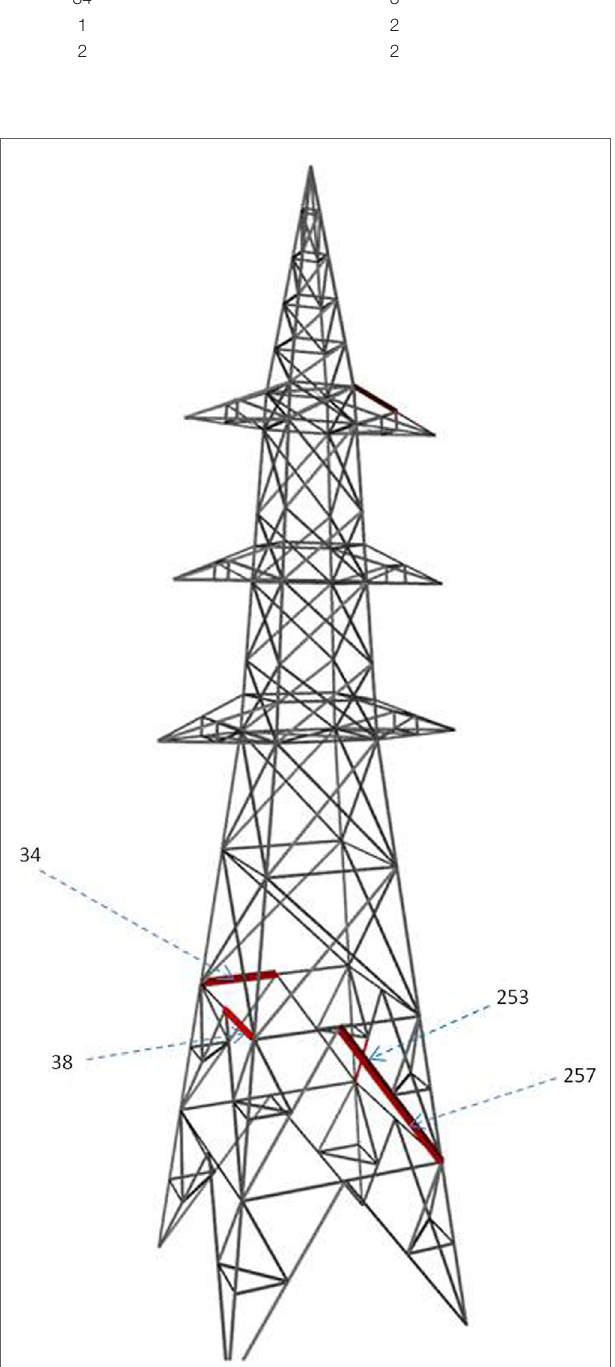
FigUre 5 | Optimal sensor locations .